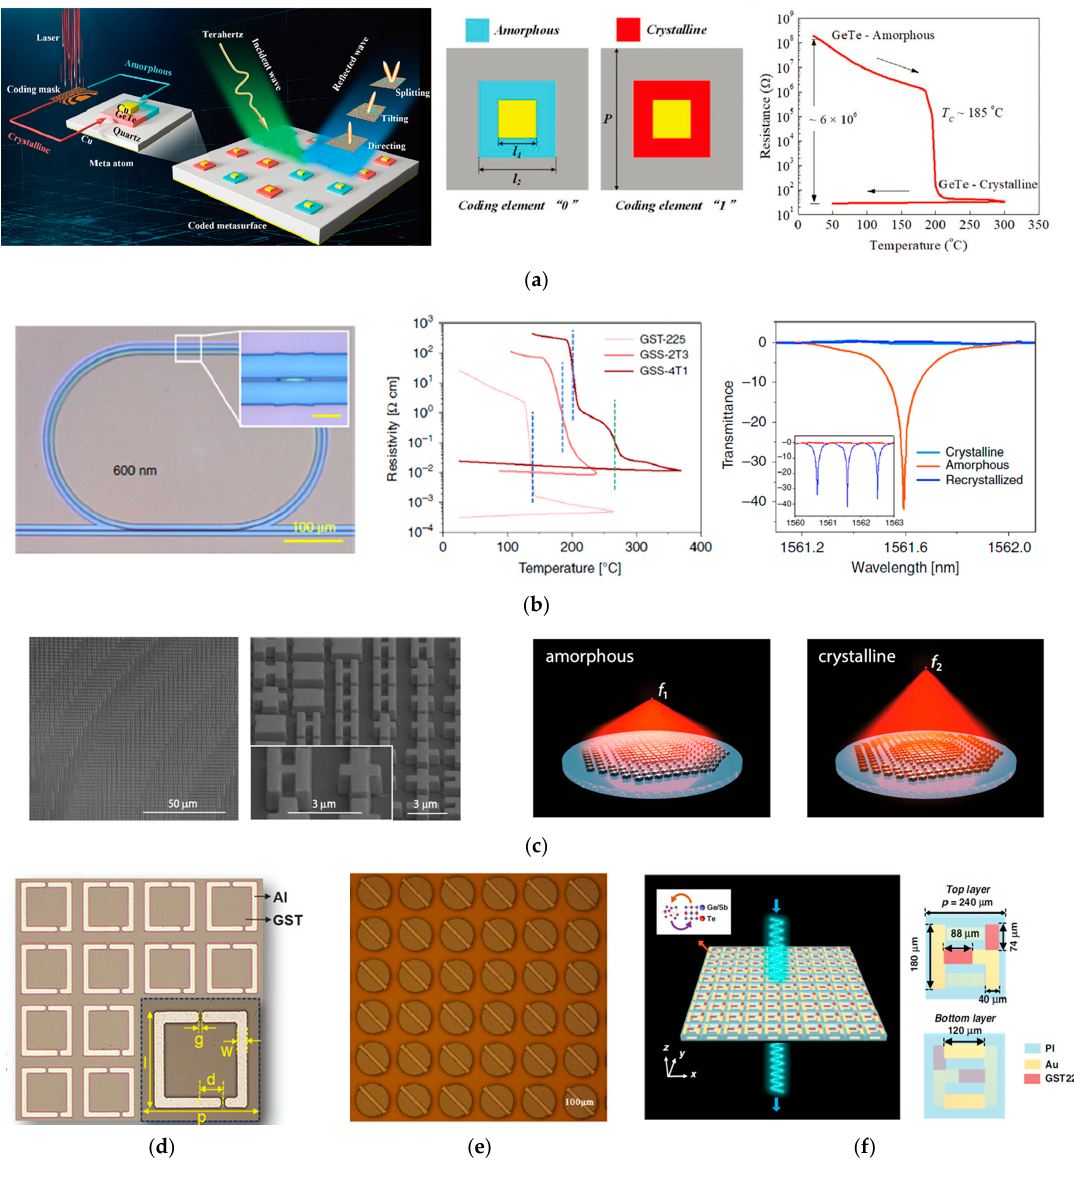
Figure 9. Chalcogenides and active metasurfaces with chalcogenides. ( a ) Programmable metasur- faces with GT [161]. The phase transition temperature is ~185°. Copyright John Wiley and Sons, 2022. ( b ) Reconfigurable optical resonator switch with Ge 2 Sb 2 Se 4 Te 1 and temperature dependence of resistivity of Ge 2 Sb 2 Te 5 , Ge 2 Sb 2 Se 2 Te 3 , and Ge 2 Sb 2 Se 4 Te 1 [162]. ( c ) Reconfigurable all − dielectric metalens with diffraction − limited performance controlled by Ge 2 Sb 2 Se 4 Te 1 [13]. ( d ) Active metasurfaces with Ge 2 Sb 2 Te 5 at terahertz frequencies [167]. Copyright John Wiley and Sons, 2019. ( e ) Broadband polarization converter with cut − wire metamaterials and Ge 2 Sb 2 Te 5 [168]. ( f ) Nonvolatile chiral metasurface switches with Ge 2 Sb 2 Te 5